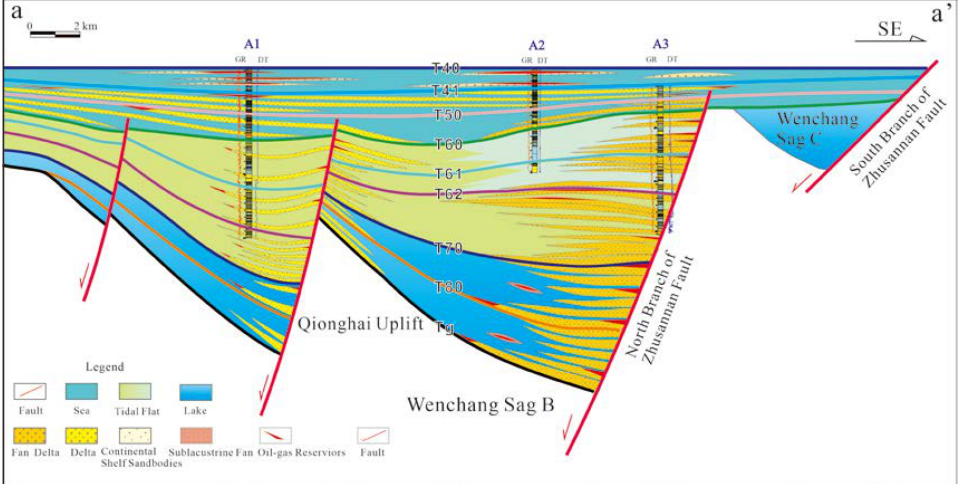
Figure 13. The type and distribution of oil and gas reservoirs across the representative section in the Zhu III Depression, PRMB. The location of section aa’ is shown in Figure 1. Zhu III Depression, PRMB. The location of section aa’ is shown in Figure